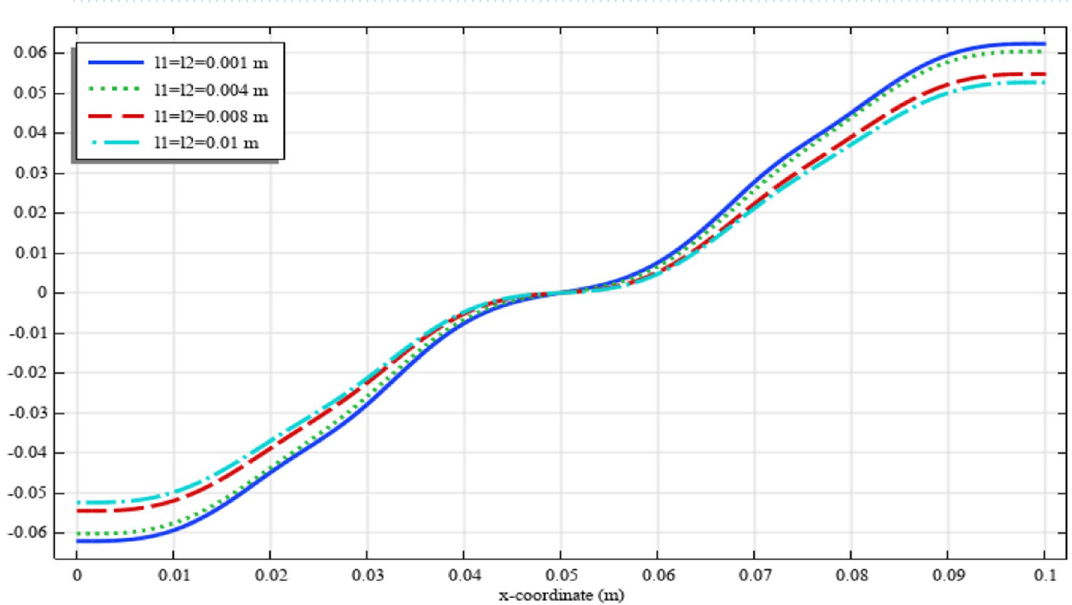
/ s 0 for different values of ℓ 1 and ℓ 2 (COMSOL x , y (cid:31) (cid:30)